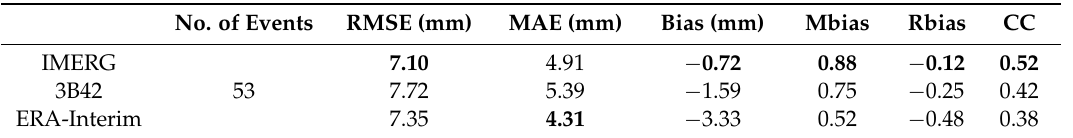
Table 6. Statistical indices of daily precipitation events in Kermanshah area (mid-March 2014 to February 2015).